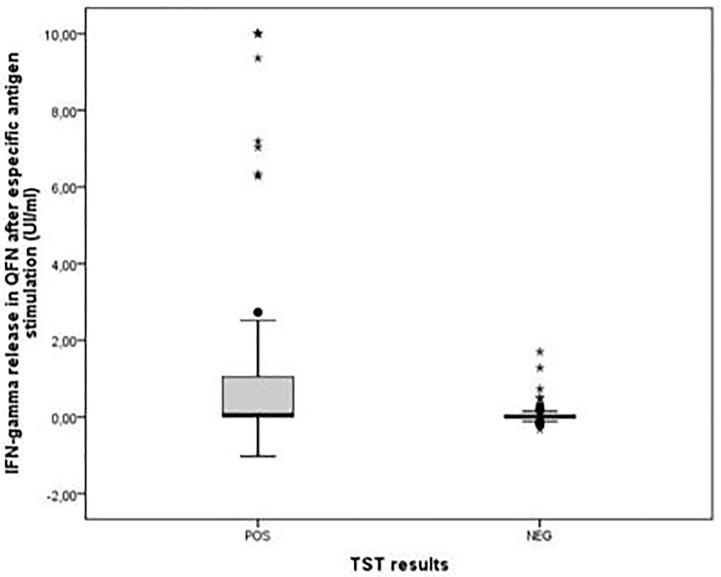
Quantification of the IGRA according to TST result.